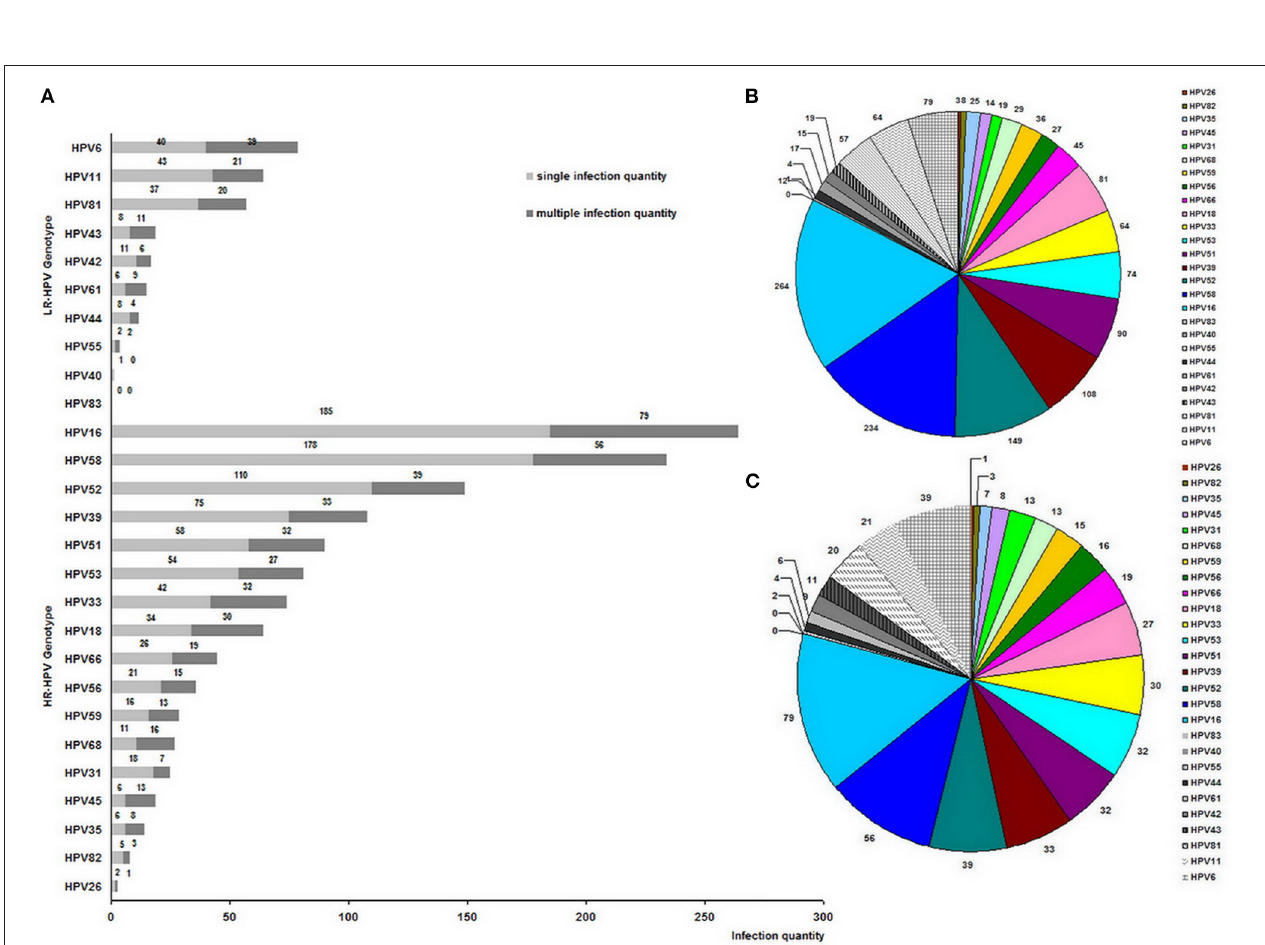
FIGURE 2 | Genotype distribution of 1,538 clinical HPV strains among 1,224 HPV-positive women (A) , and genotype proportion of 1,538 clinical HPV strains (B) , and 535 clinical HPV strains from multiple infections (C) .